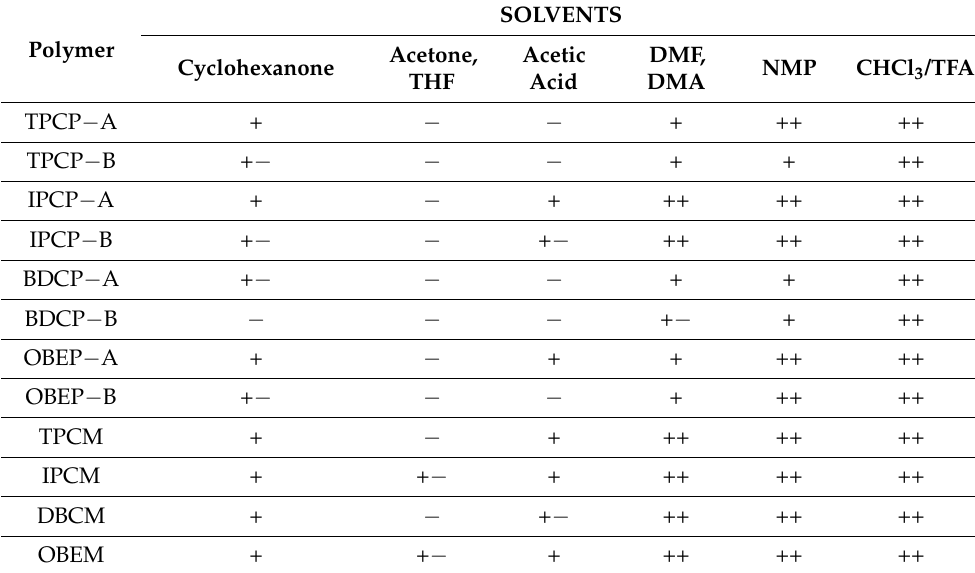
Table 3. Solubility of poly(ether amide)s (++ = soluble at room temperature; + = soluble on heating; + − = partially soluble; − =